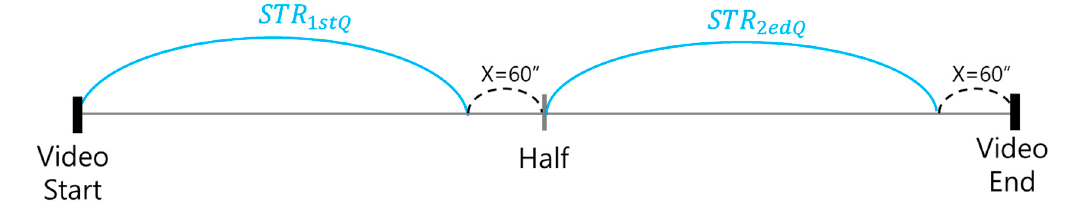
Figure 5. Quiz appearance time range.